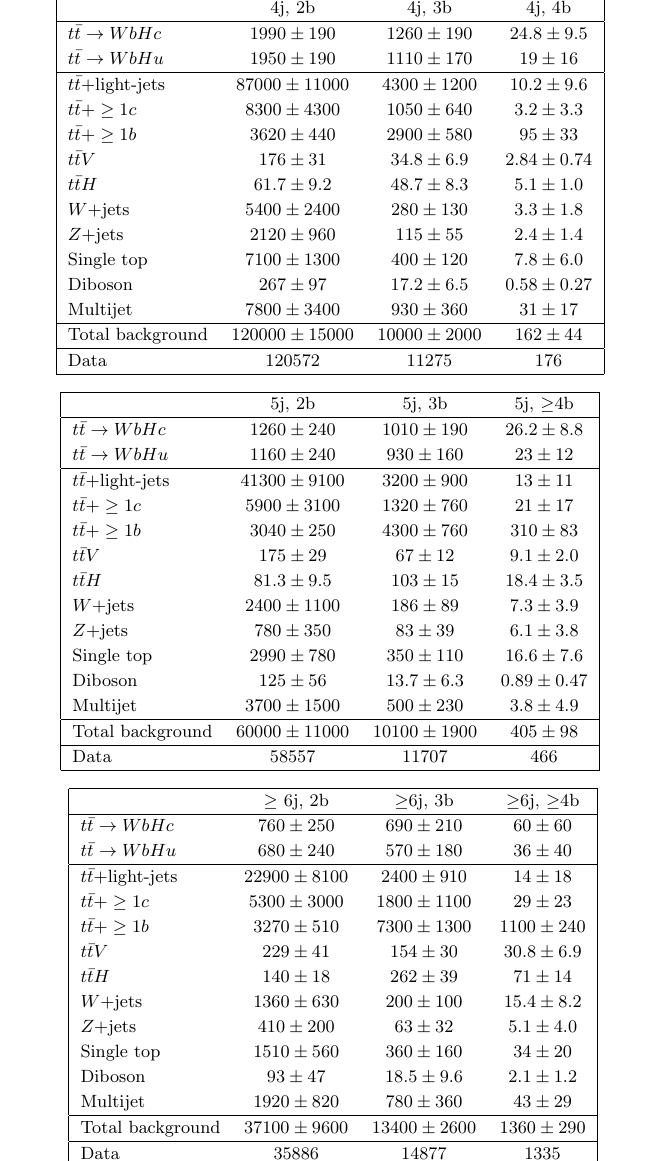
Table 4 . tqH ( b (cid:22) b ) search: predicted and observed yields in each of the analysis regions considered. The prediction is shown before the (cid:12)t to data. Also shown are the signal expectations for t (cid:22) t ! WbHc and t (cid:22) t ! WbHu assuming B ( t ! Hc ) = 1% and B ( t ! Hu ) = 1% respectively. The quoted uncertainties are the sum in quadrature of statistical and systematic uncertainties of the yields, excluding the normalisation uncertainty of the t (cid:22) t + (cid:21) 1 b background, which is determined via a likelihood (cid:12)t to data.